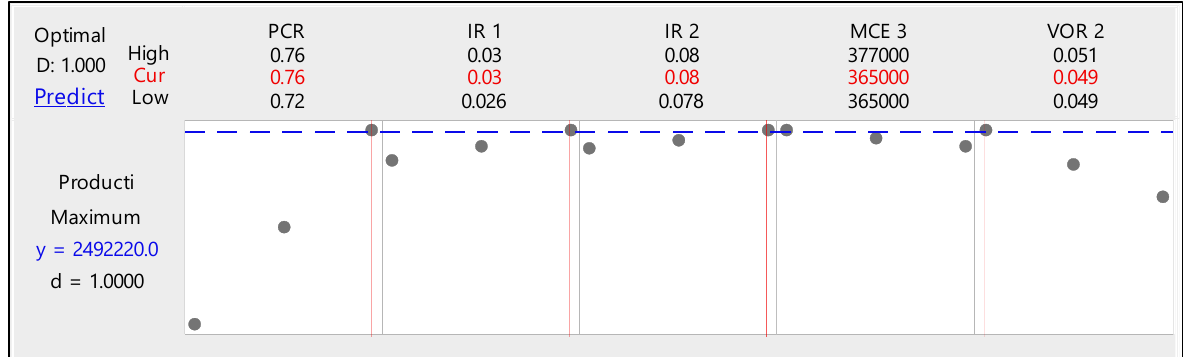
Figure 9. Diagram of the optimal values to maximize